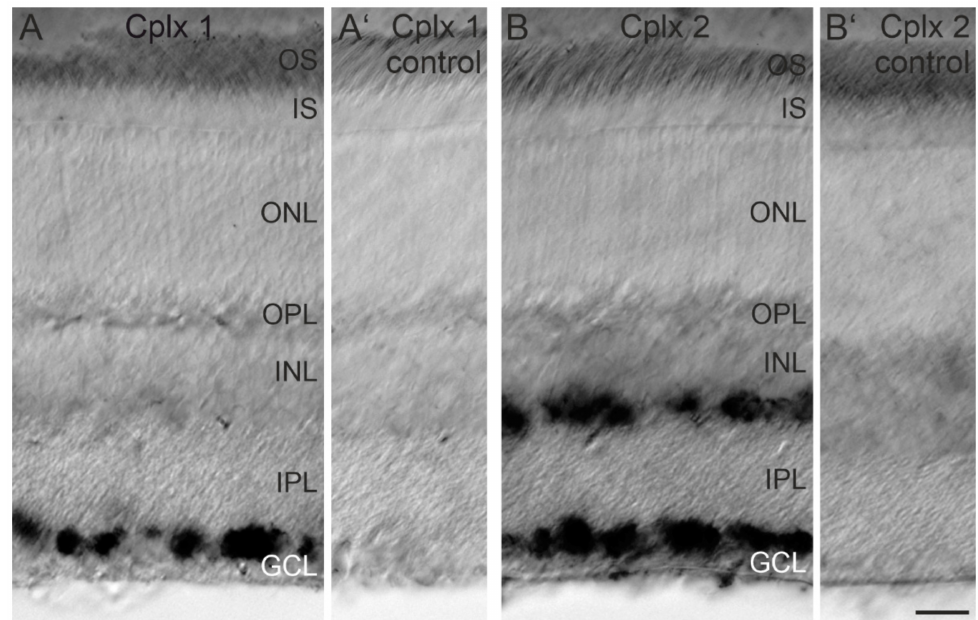
Figure 2. Expression of Cplx 1 and Cplx 2 mRNA in the inner nuclear layer (INL) and ganglion cell layer (GCL) of mouse retina. ( A ) Strong in situ hybridization signal for Cplx 1 mRNA in the GCL. ( A (cid:48) ) No signal for Cplx 1 with the sense control. ( B ) Strong in situ hybridization signal for Cplx 2 mRNA in the INL and GCL. ( B (cid:48) ) No signal for Cplx 2 with the sense control. OS, outer segments; IS, inner segments; ONL, outer nuclear layer; OPL, outer plexiform layer; IPL, inner plexiform layer. Scale bar = 20 µ m in ( B (cid:48) ) for ( A – B (cid:48)